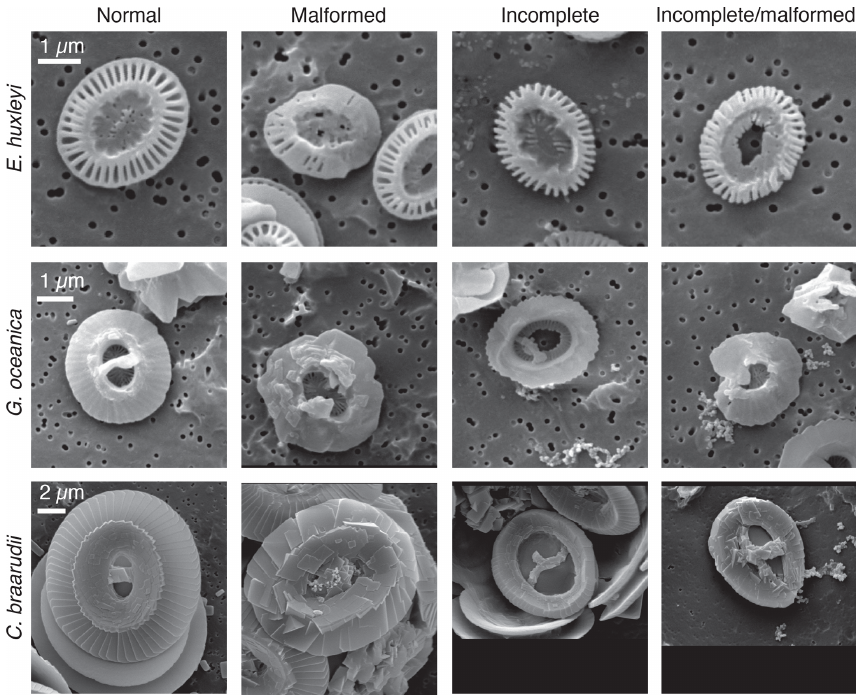
Figure 2. Examples of different morphological categories: normal, malformed, incomplete, and incomplete/malformed for E. huxleyi, G. oceanica and C. braarudii